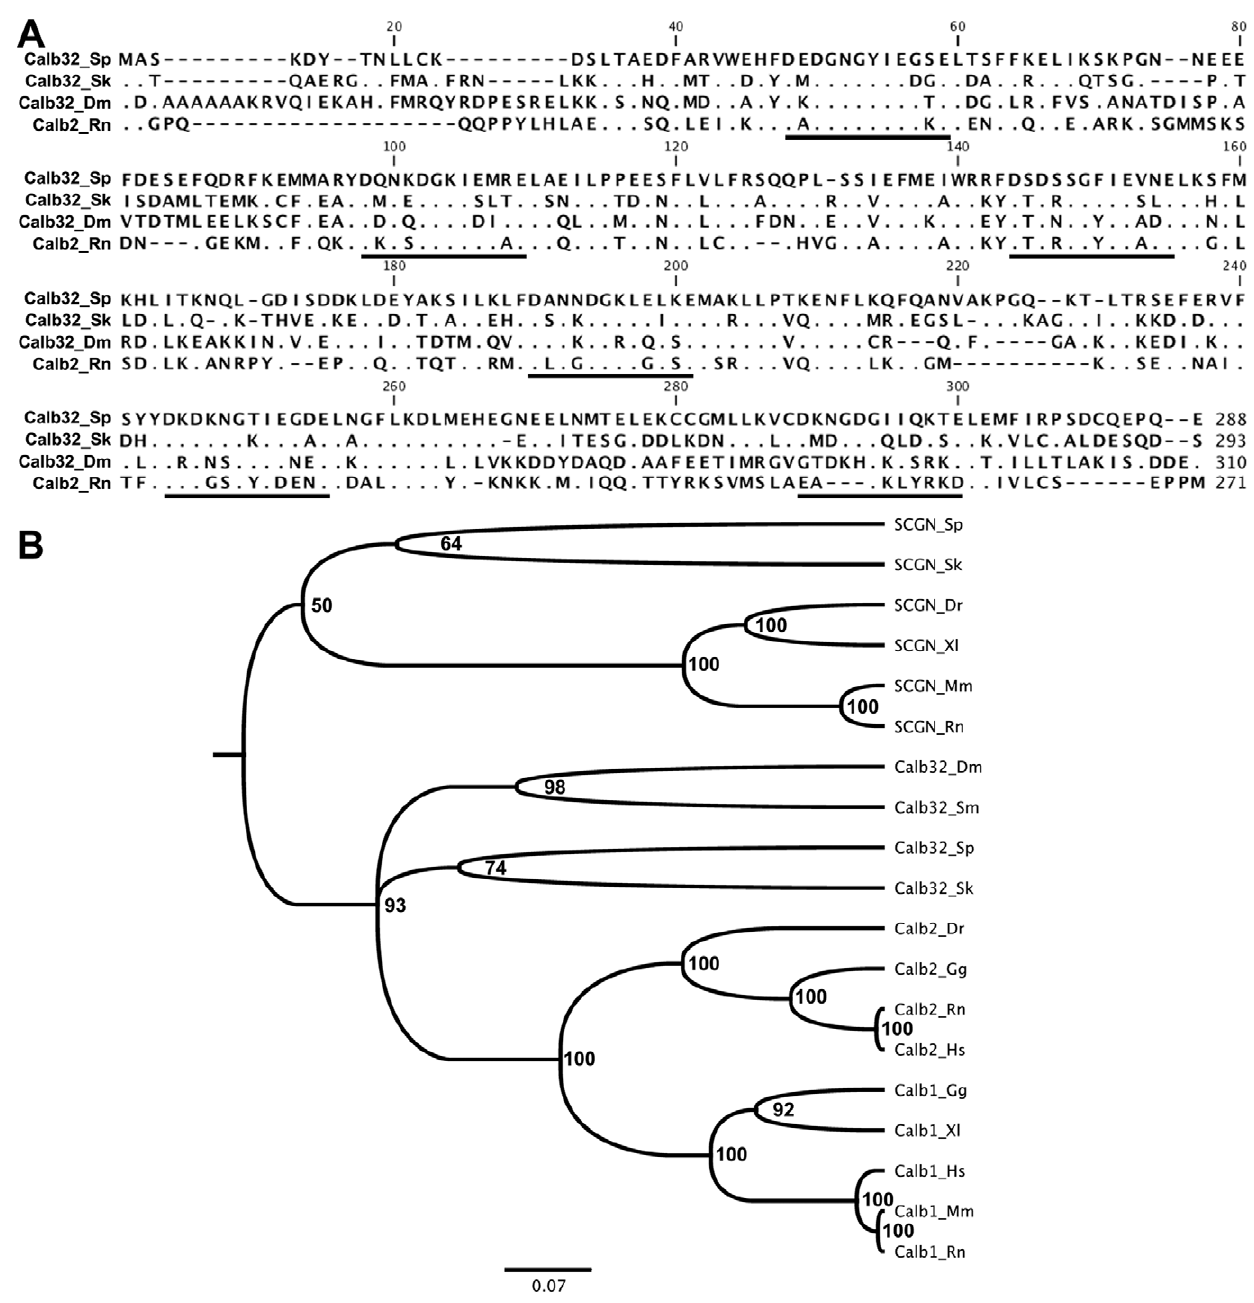
Figure 6. Alignment of the peptide sequences and phylogenetic trees of members of the calbindin subfamily from different species. (A) Sequence alignment of rat calbindin 2 (NP_446440.1), Drosophila calbindin-D32k (NP_476838.1), S. kowalevskii calbindin-D32k (XP_002735965.1), and S. purpuratus calbindin-D32k proteins (XP_781517.2). Alignment of the proteins was made using the CLUSTALW multiple sequences alignment. Dots represent conserved residues and black lines below the residues represents the presence of an EF hand domain. (B) Phylogenetic tree of members of the calbindin subfamily from different species. Calb32_Dm Drosophila melanogaster (NP_476838.1), Calb32_Sk S. kowalevskii (XP_002735965.1), Calb32_Sp S. purpuratus (XP_781517.2), Calb32_Sm S. mansoni (XP_002574332.1), Calb2_Gg G. gallus (NP_990647.1), Calb2_Dr D. rerio (NP_957005.1), Calb2_Rn R. norvegicus (NP_446440.1), Calb2_Hs H. sapiens (NP_001731.2), Calb1_Xl X. laevis (NP_00108408.1), Calb1_Gg G. gallus (NP_990844.1), Calb1_Mm M. musculus (AAH16421.1), Calb1_Rn R. norvegicus (AAH81764.1), Calb1_Hs H. sapiens (NP_004920.1), SCGN_Sk S. kowalevskii (NP_001161653.1), SCGN_Sp S. purpuratus (XP_785060.2), SCGN_Dr D. rerio (NP_001005776.1), SCGN_Xl X. laevis (NP_001088097.1), SCGN_Rn R. norvegicus (NP_963855.1), SCGN_Mm M. musculus (NP_663374.1). The phylogenetic tree was constructed from an alignment created by using the unweighted pair group method with arithmetic mean. The scale bar represents 100 times the expected number of amino acid substitution.